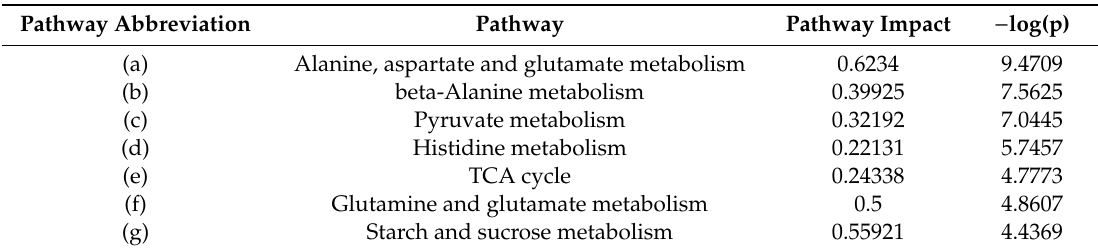
Table 2. Pathway entities with quality criteria and statistics from analysis shown in Figure